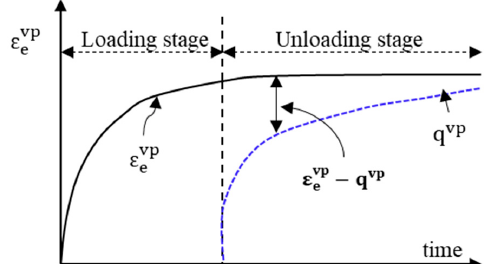
Figure 9. Schematic—the evolution of the effective viscoplastic strain and the hardening–relaxation during loading–unloading cycle. ( ε (cid:2915)(cid:2932)(cid:2926) − q (cid:2932)(cid:2926) the driving force for viscoplastic softening or recovery during loading–unloading cycle. ( ε vp e − q vp the driving force for viscoplastic softening or in the viscoplastic hardening). Adapted with permission from [ 23 ] , 2012, International Journal of Plasticity, Elsevier.